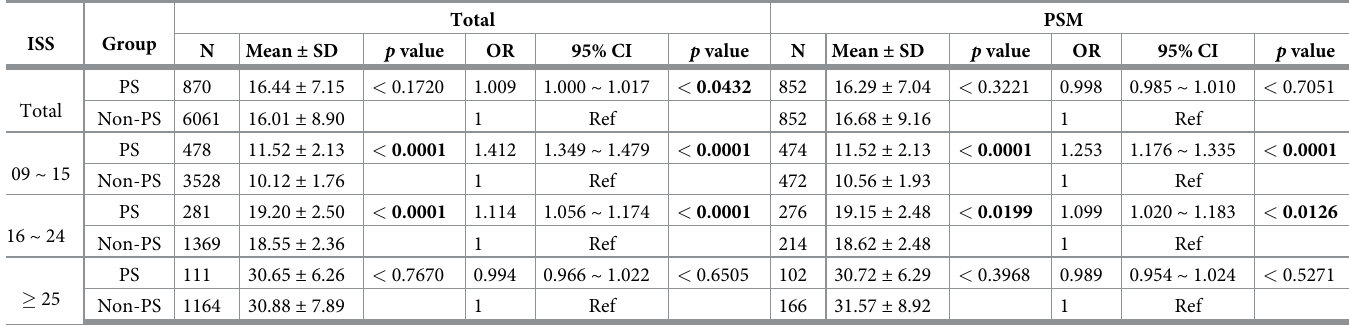
Table 2. Regression analysis of Injury Severity Score